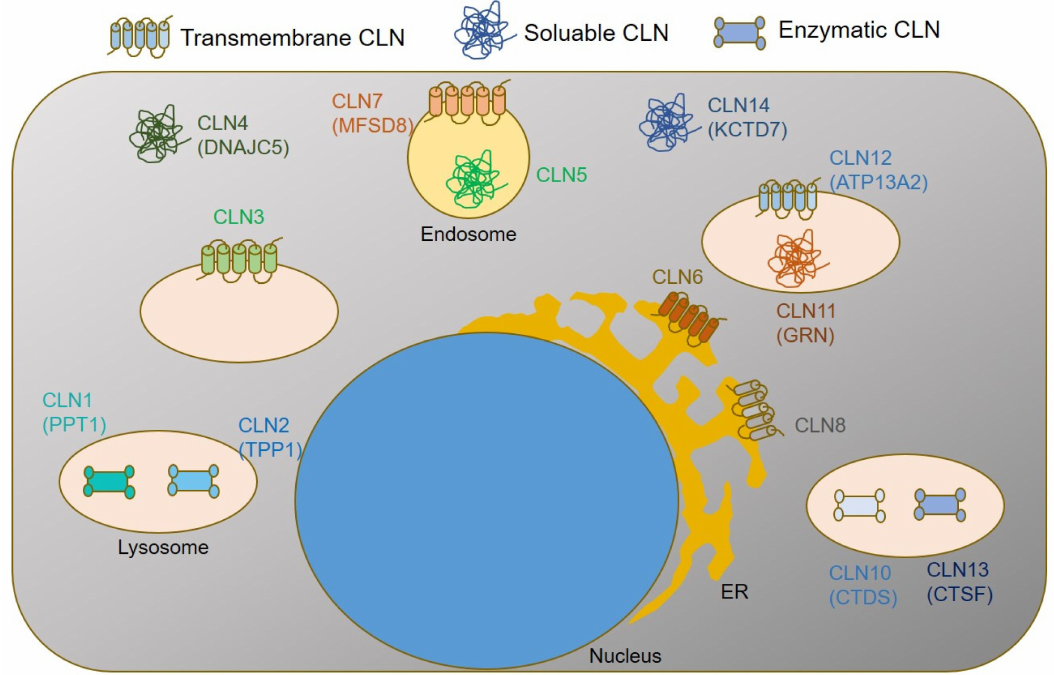
Figure 1. Simplified graphical summary of subcellular CLN protein localizations and